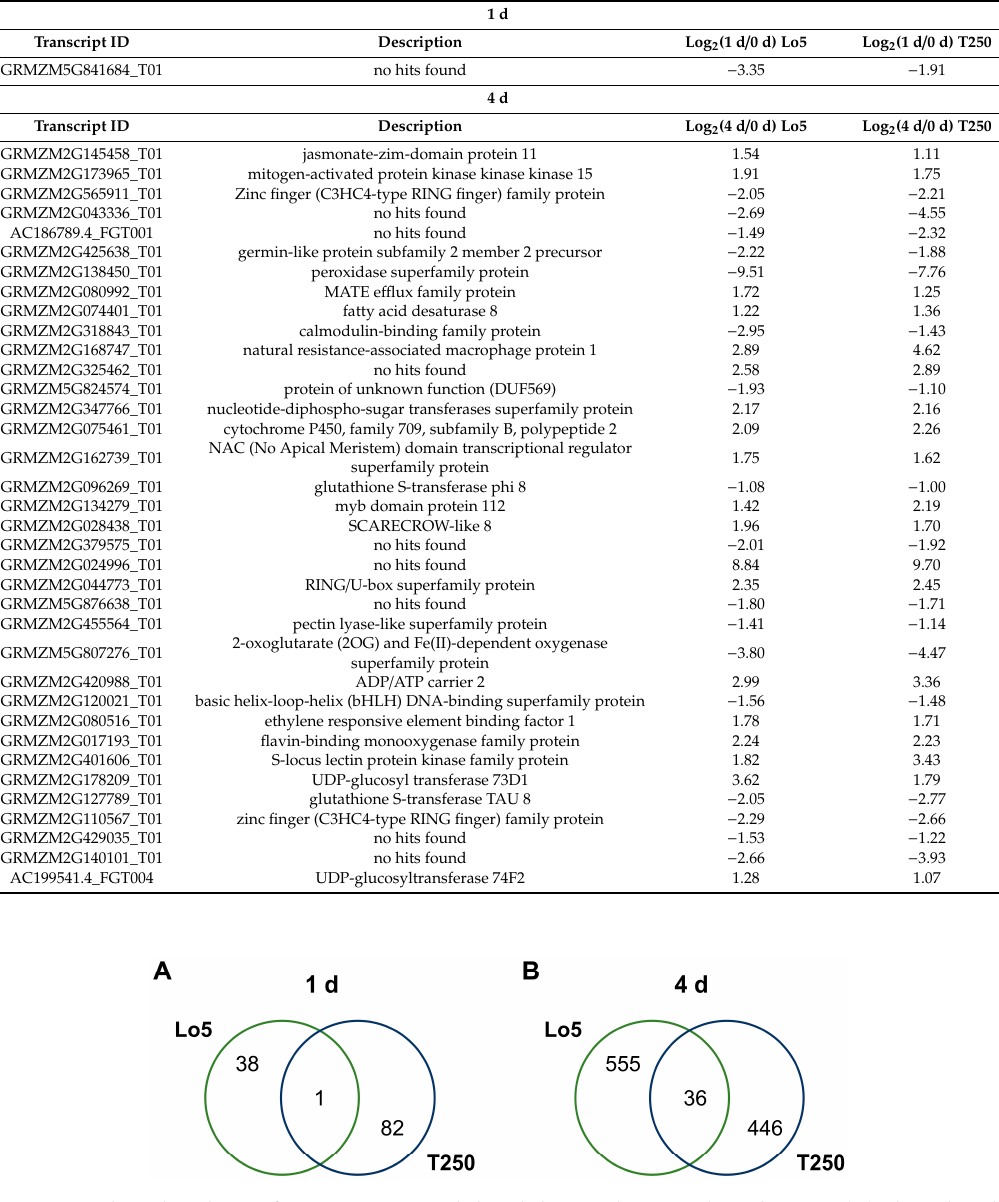
Figure 1. Shared and specific transcripts modulated during the growth without N. ( A ) Shared and specific transcripts modulated between Lo5 and T250 at 1 d. ( B ) Shared and specific transcripts modulated between Lo5 and T250 at 4 d.